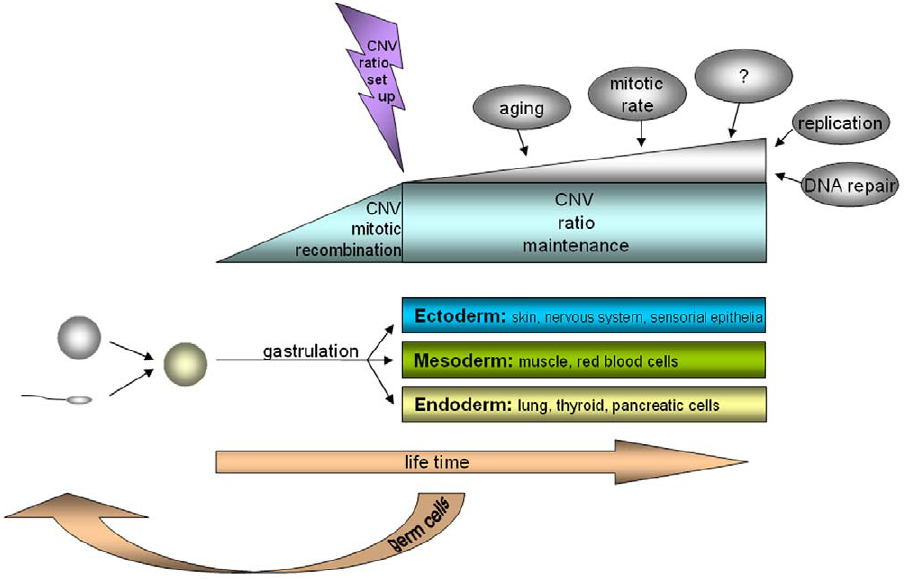
Figure 3. Scheme for the development of somatic CNV mosaicism. Parental germ cells with a certain haploid pattern of CNV fuse to a zygote with a defined diploid pattern of CNV. It is hypothesized that in early embryogenesis, the mitotic recombination of single CNV occurs, leading to a somatic mosaicism in the CNV pattern, which is stable until at least the end of gastrulation and the formation of the germ layers. The ratio of this CNV mosaicism is stable over a lifetime and across different cell types, except when other factors directly influence DNA stability.